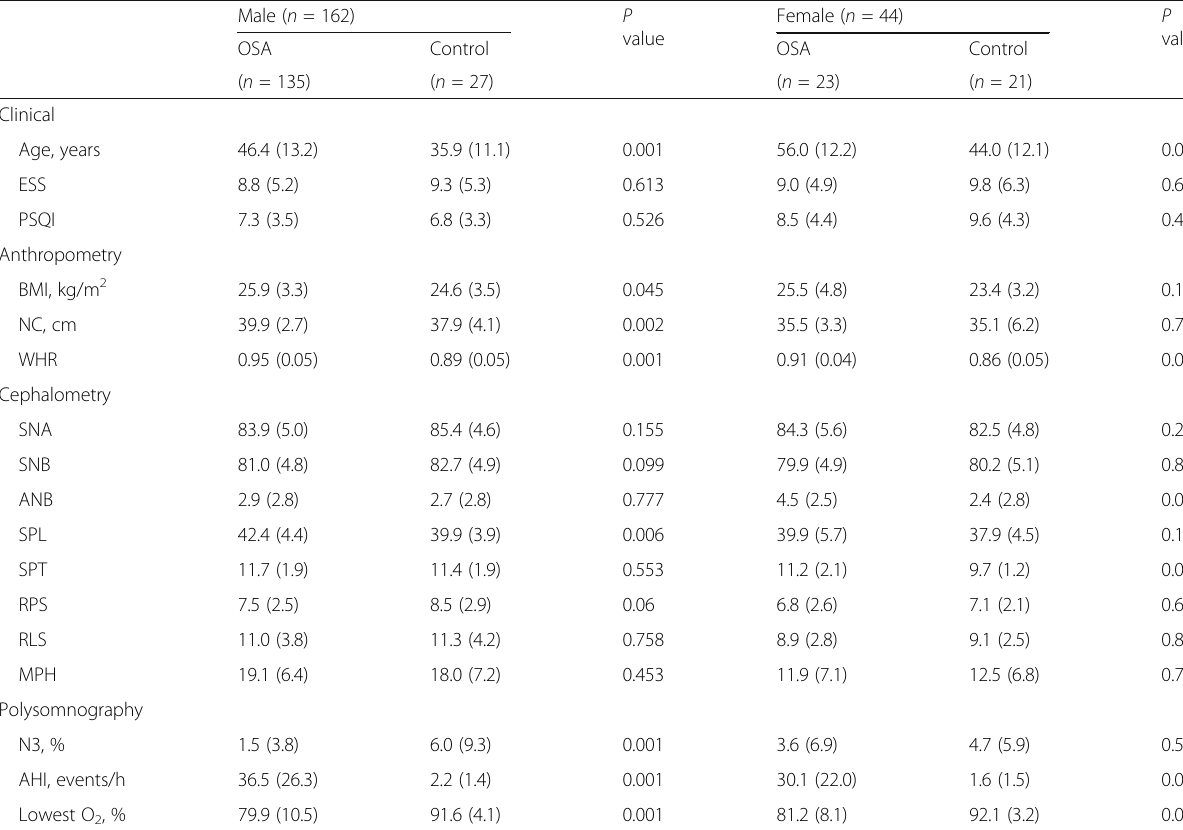
Table 2 Gender effects on cephalometric differences between OSA and control patients